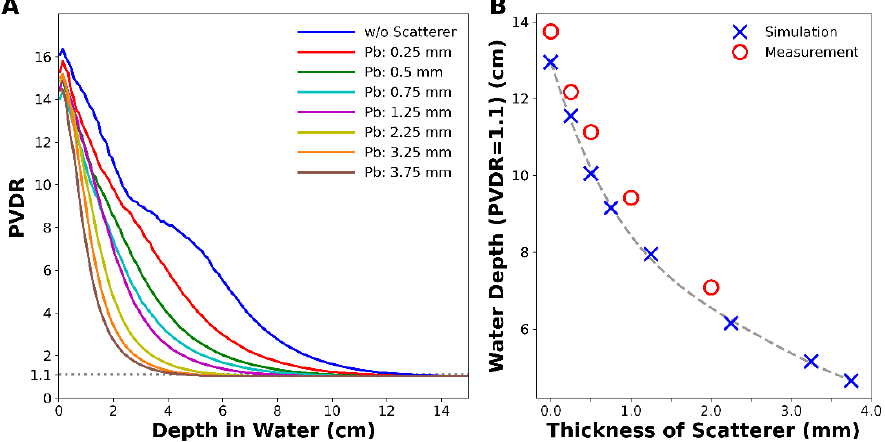
Figure 4. MC simulation of ( A ) PVDR with depth for various thicknesses of lead scatterer and ( B ) depth at which the PVDR became 1.1. Measured data were corrected by considering water-equivalent thickness of PMMA.